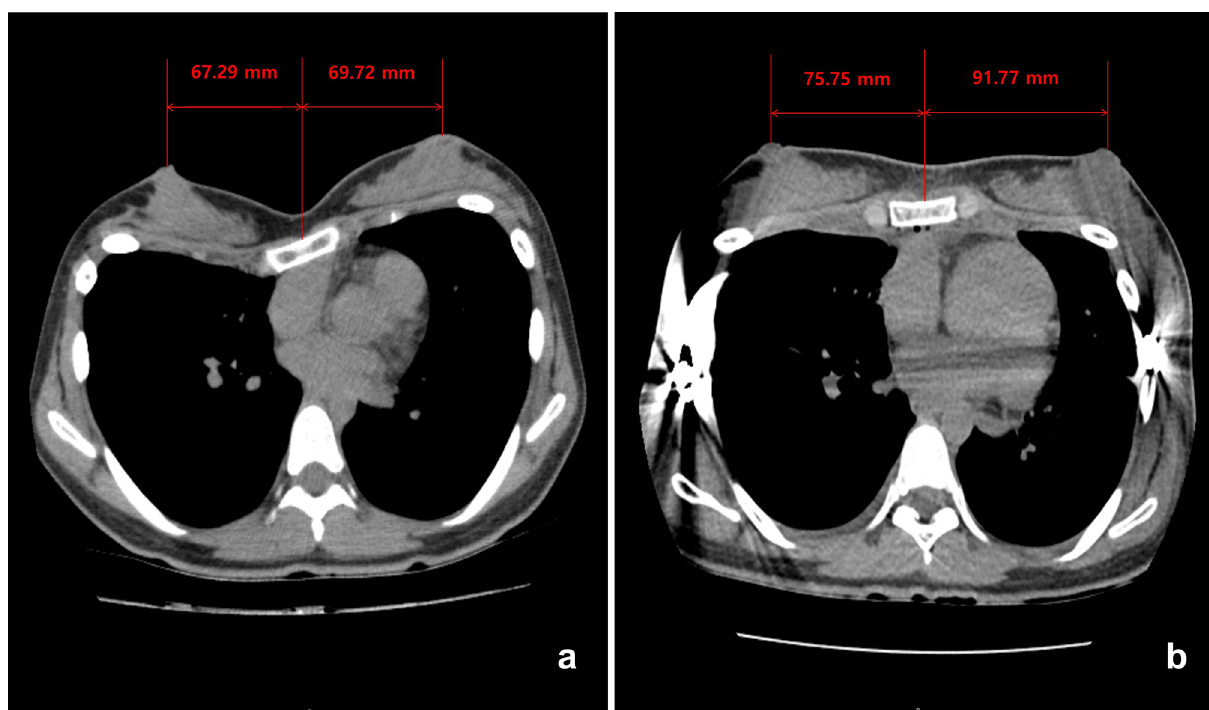
Figure 2. Nineteen year-old women pectus excavatum patient who had a modified Nuss repair. ( a ) The distance between nipples was 137.01 mm before modified Nuss procedure. ( b ) The distance between nipples was 167.52 mm after modified Nuss